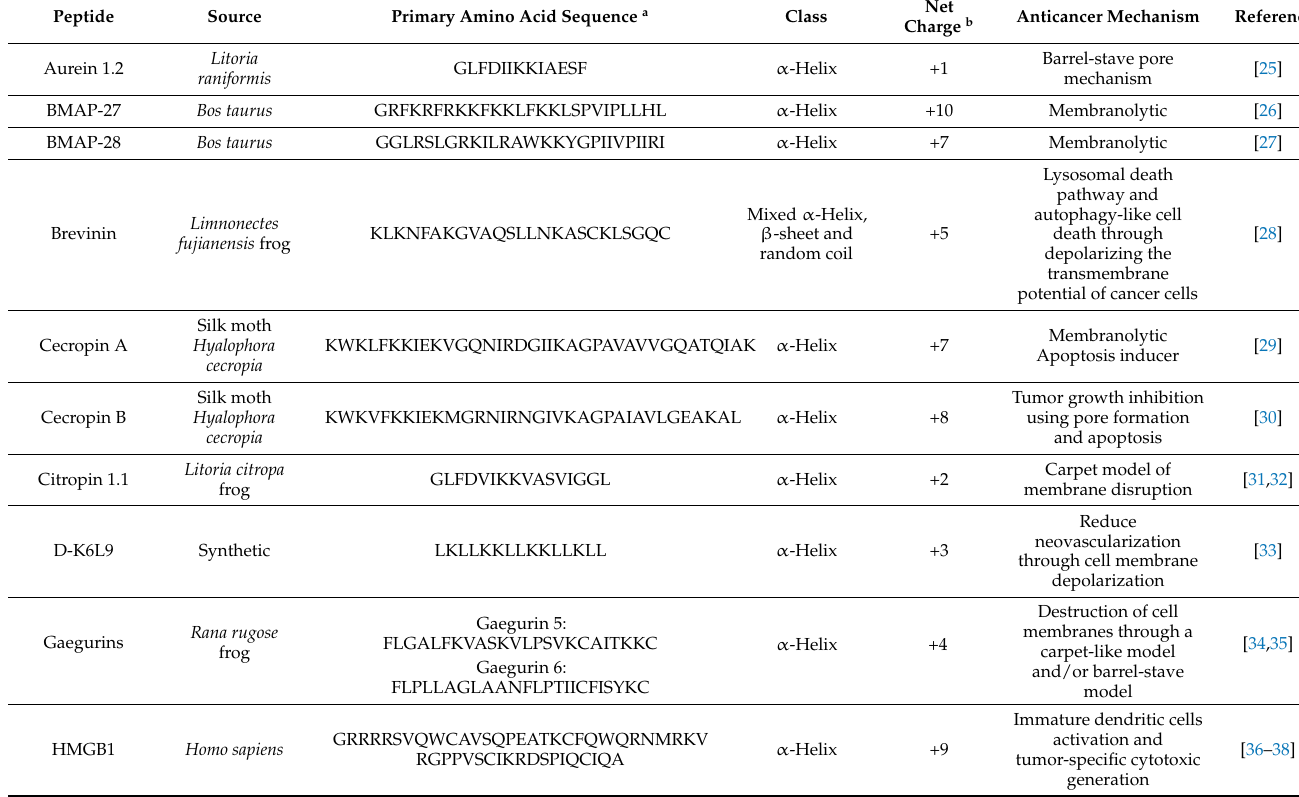
Table 1. Summary of ACPs discussed in this